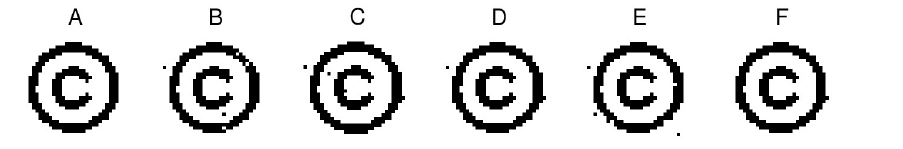
Fig 2. The proposed scheme used to extract the watermark